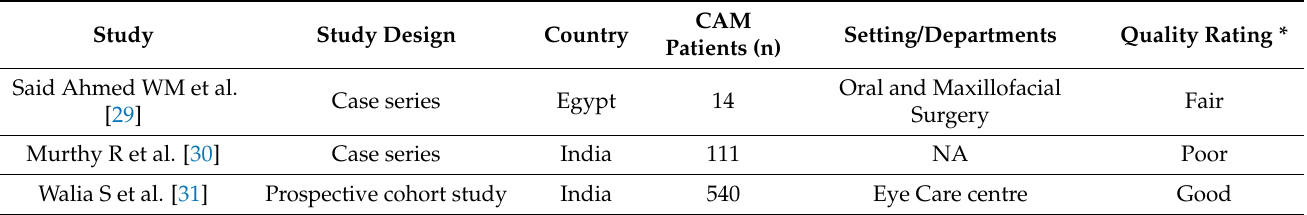
Table 1. Studies’ characteristi cs .